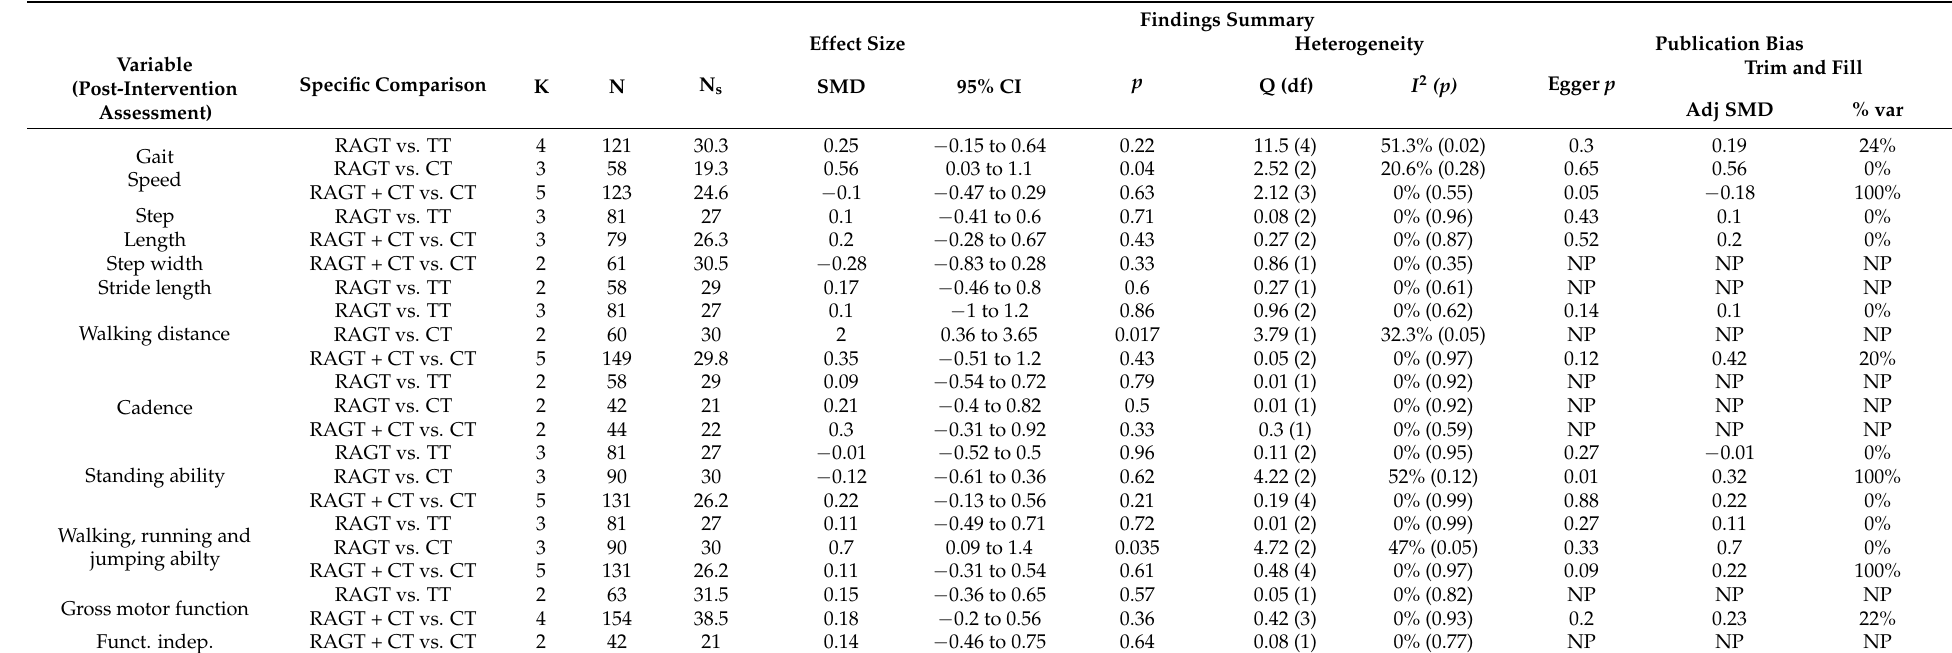
Table 5. Main findings in